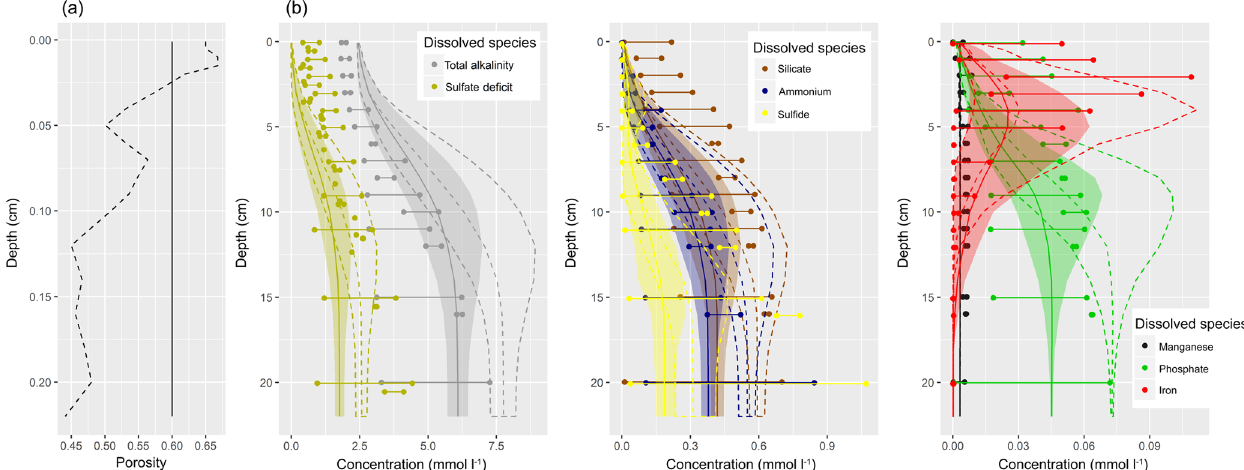
Figure D1. (a) Porosity at the silt station Tromper Wiek as assumed in the model (solid line) and a porosity profile for a realistic model set-up derived from the April 2014 cruise (dashed line). (b) Pore water concentrations of several dissolved species at the silt station Tromper Wiek. Points and horizontal lines indicate the range of measurements. Solid curves and shading present the original model results and indicate year-average concentrations and the seasonal range. Dashed curves show the same, but for a model version with the realistic porosity